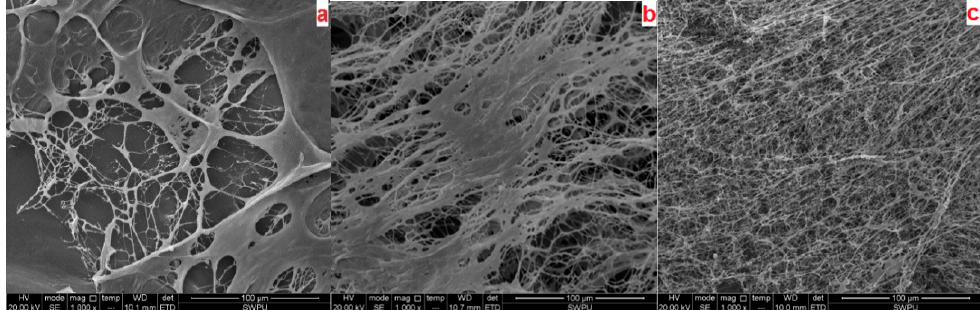
Figure 17. SEM of 0.15 wt.% drag reducers in brine (10 × 10 4 mg / L) containing Mg 2 + (1000 mg / L):